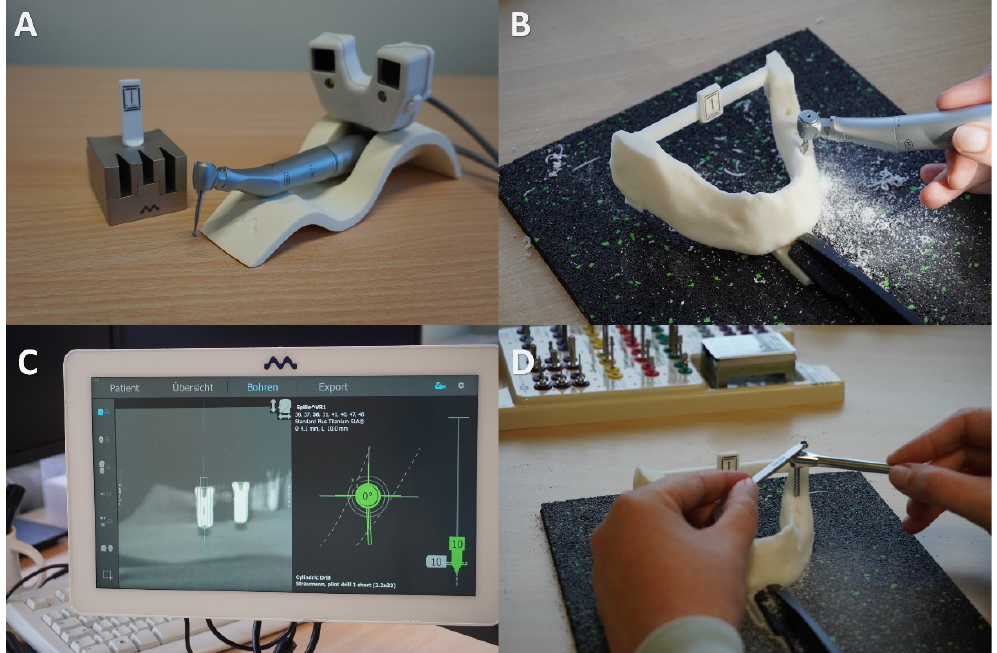
Figure 2. Illustrated is the dynamic workflow. In ( A ), a young professional registered the right drill, then the drilling could be performed with the Denacam navigation system ( B ). In ( C ), the young professional could see the right position of the drill in all relevant dimensions (angle, basis, apex). In ( D ), the young professional placed the implant in the drilled